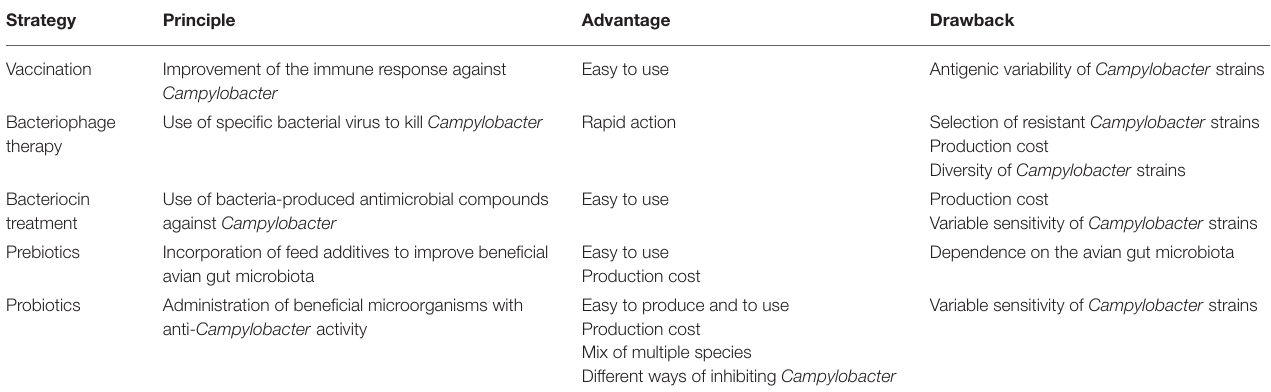
TABLE 1 | Strategies in progress to control Campylobacter at the farm level.